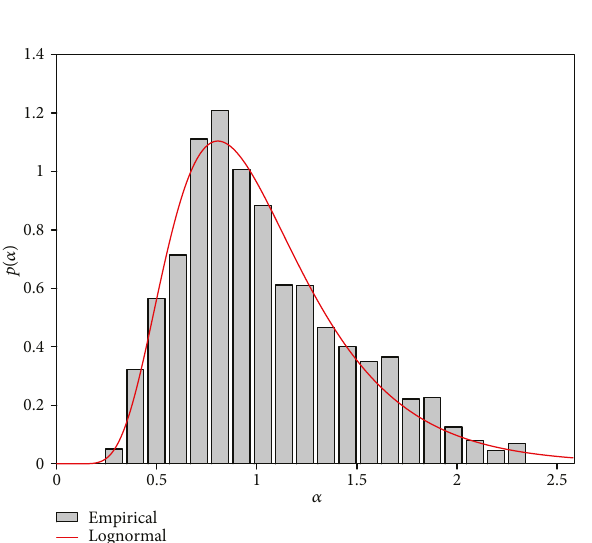
Figure 5: Exemplary slow fading distribution for C9 con fi guration and antenna placed on TO